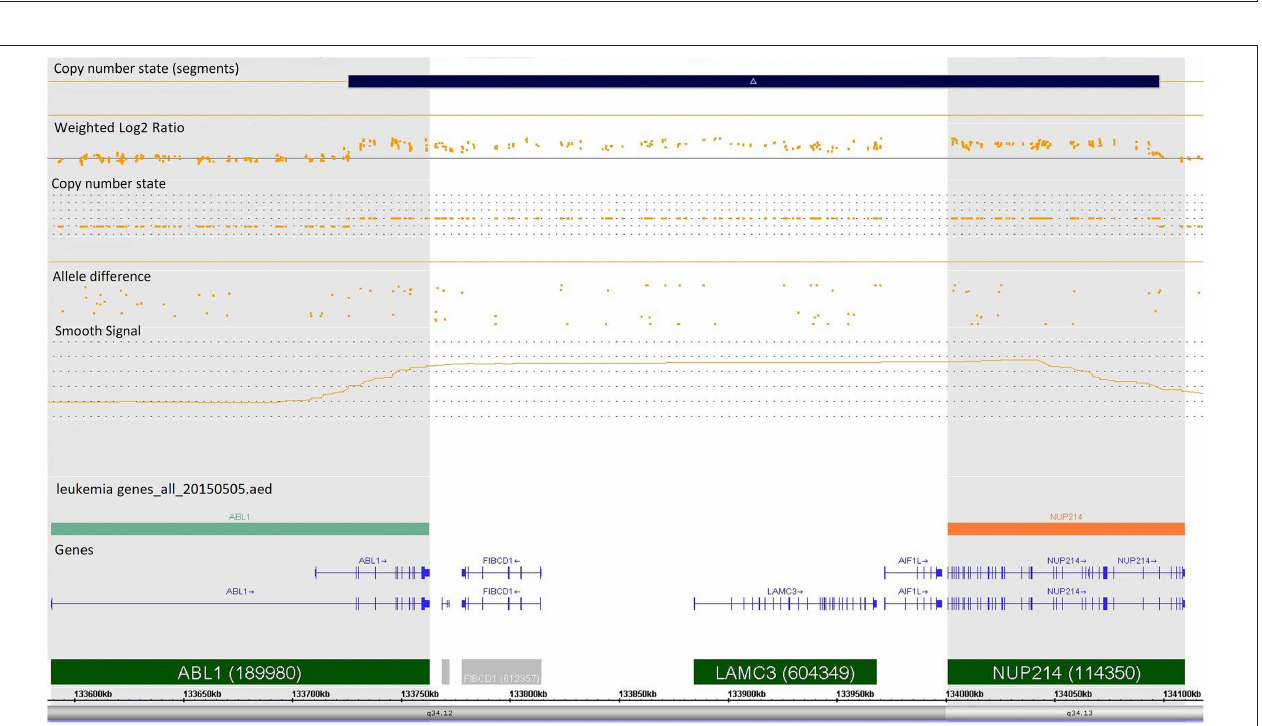
FIGURE 2 | Complex copy number gains and losses in region 11q14.1q25 of chromosome 11 in patient with T-cell ALL by single-nucleotide polymorphism (SNP) array (case z219-401). Colored segmental regions (top line: red color—deletions; blue color—gains), copy number state allele difference, and smooth signal (bottom panel) aberrations by SNP array.